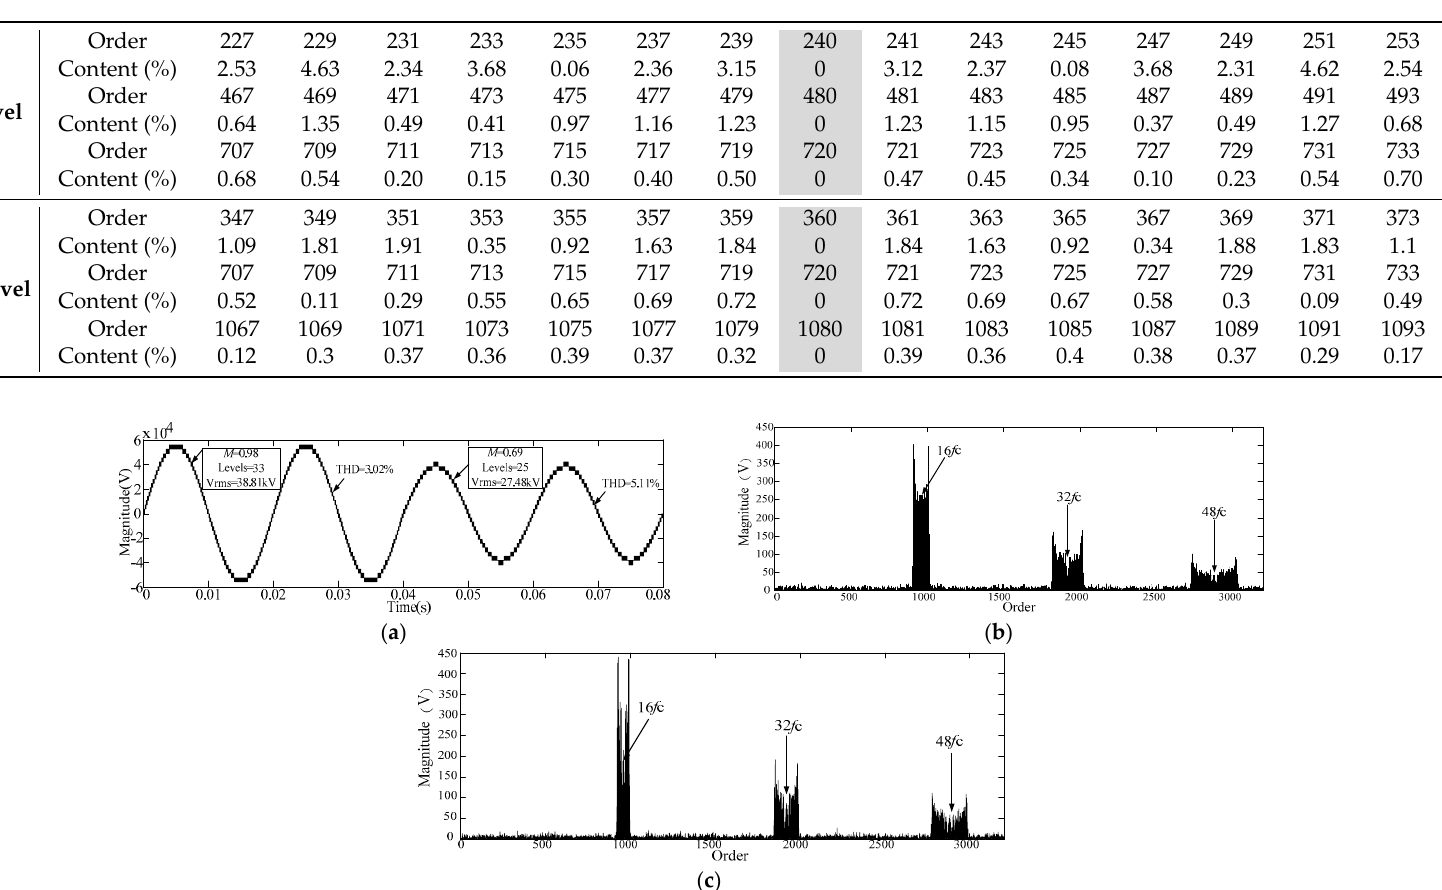
Table 3. Output Characteristic Order Harmonics Content of 2 Modules Cascaded Inverter and 3 Modules Cascaded Inverter.